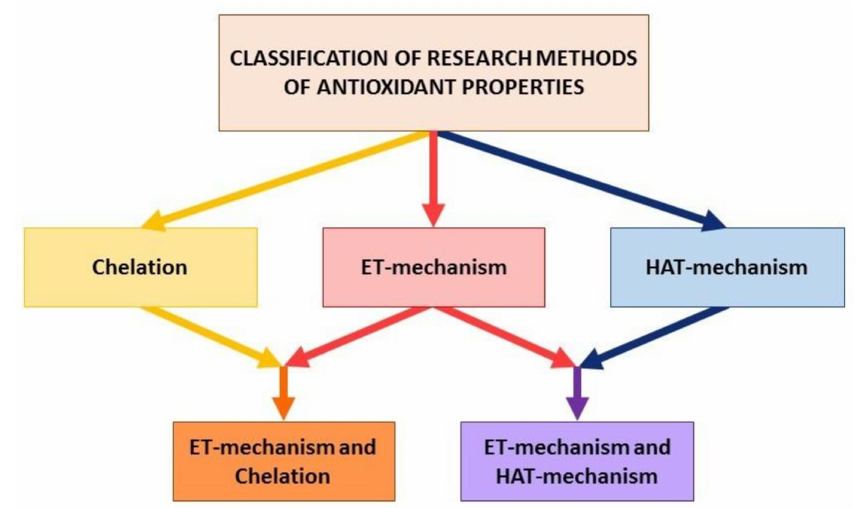
Figure 2. Classification of methods to evaluate the integrated antioxidant